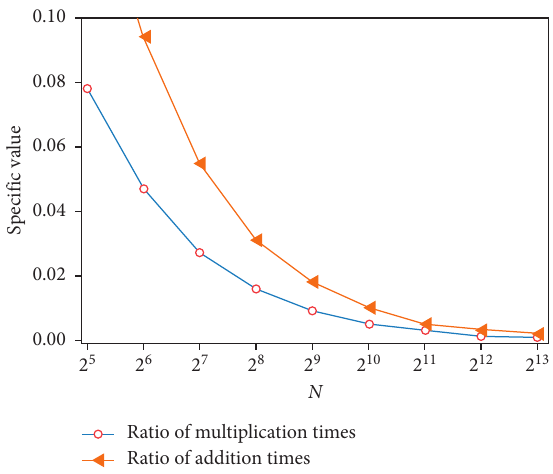
Figure 2: The variation of α